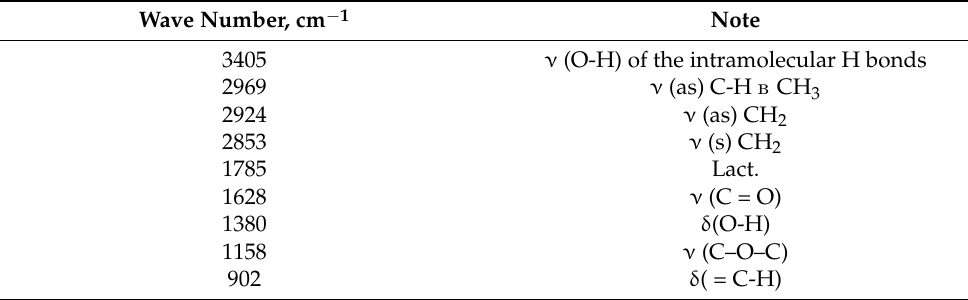
Table 7. IR characteristics of